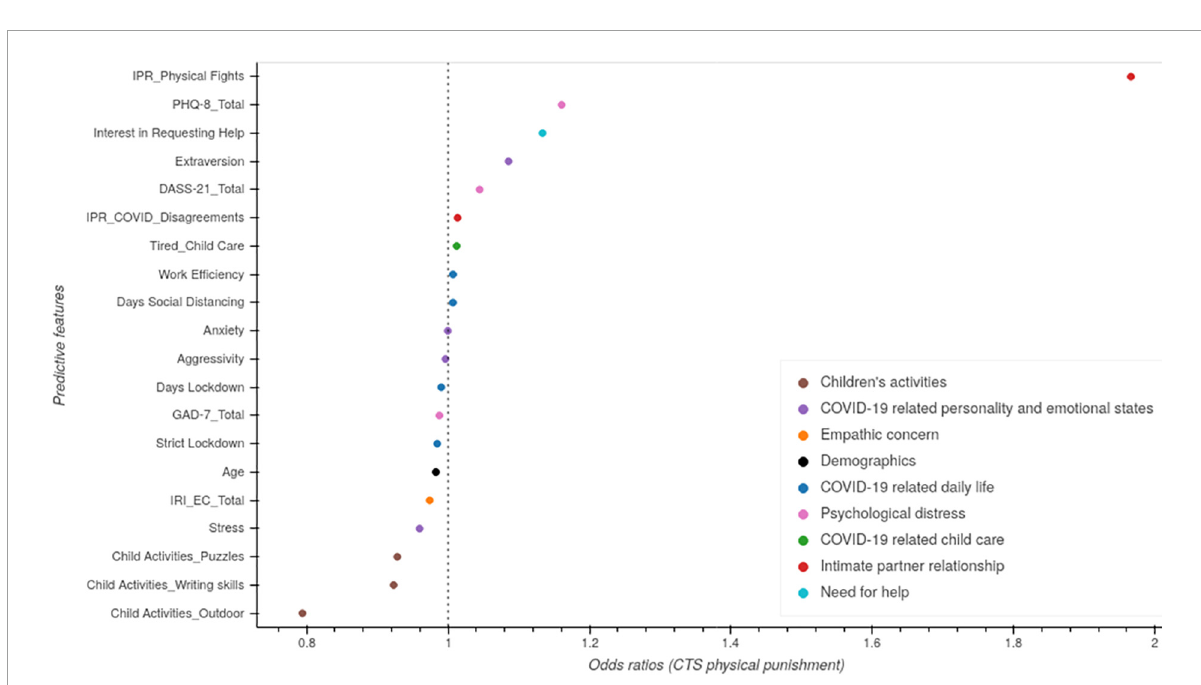
FIGURE3 Regularized regression model predicting physical punishment toward children (Time